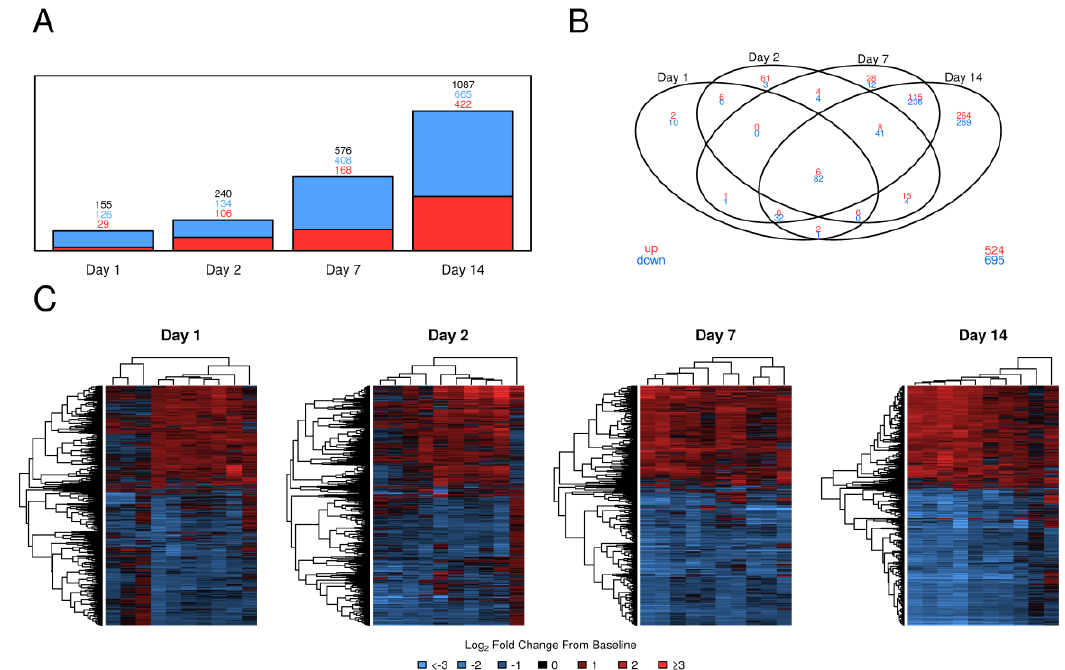
Figure 1. PBMC gene expression changes over time following tularemia live-attenuated vaccination. ( A ): Barplot summarizing DE genes over time by up / down-regulation. In red: up-regulated; in blue: down-regulated; in black: up- or down-regulated. ( B ): Venn diagram of DE genes over time. ( C ): Heatmaps of log 2 -fold change from pre-vaccination. Genes were hierarchically clustered using uncentered Pearson correlation of log 2 -fold changes in combination with the complete linkage algorithm. Gene order may differ between heatmaps.